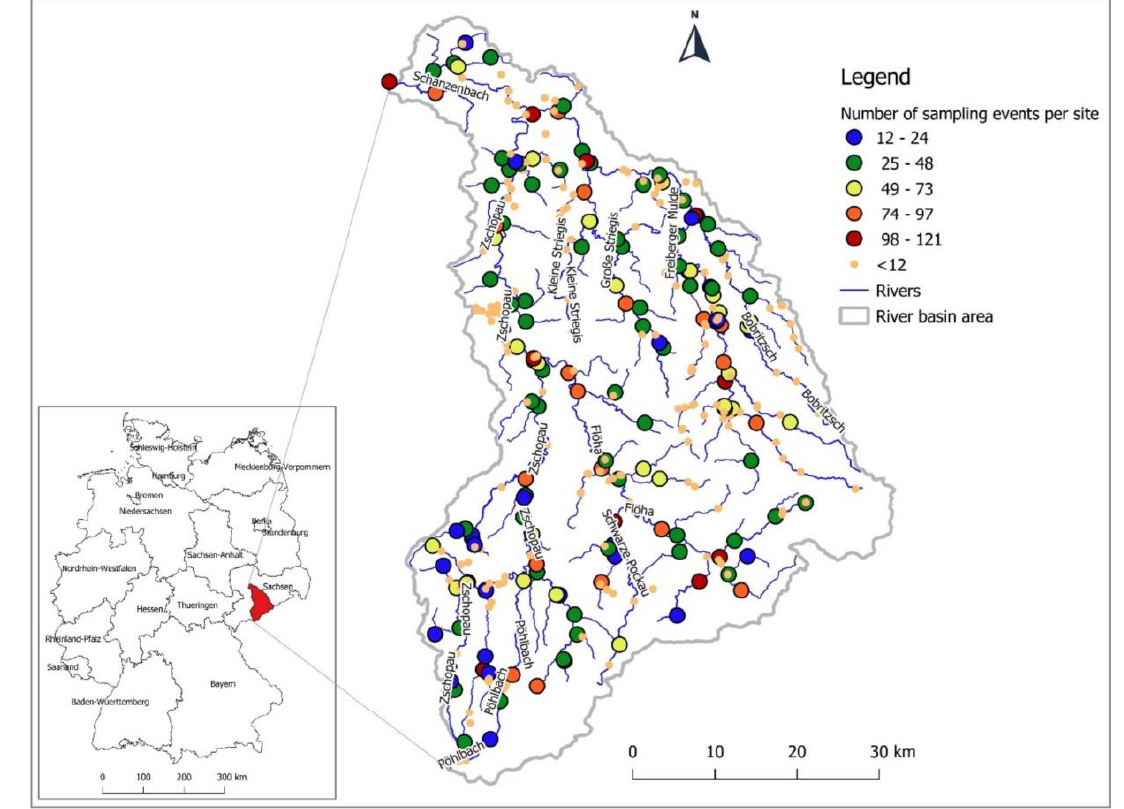
Figure 1. Location map of the study area with number of sampling events per water quality monitoring (WQM) site during the monitoring period of 2006 to 2016 on the Freiberger Mulde river basin in eastern Germany.